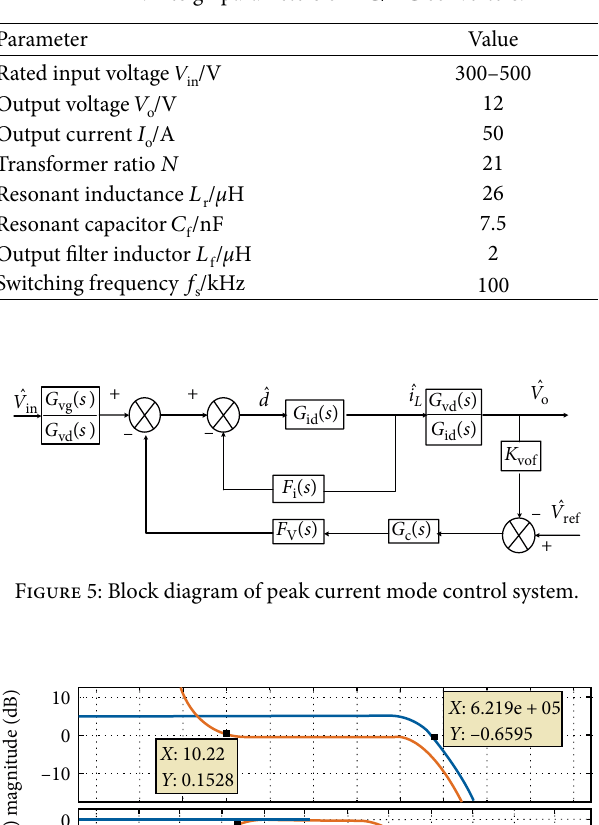
Figure 4: Duty cycle change caused by output voltage error disturbance.